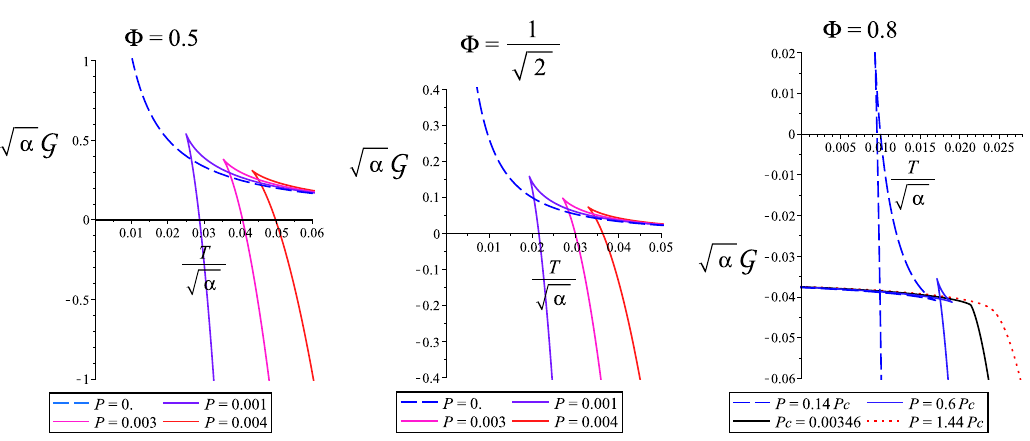
Figure 11 . Thermodynamic potential in grand canonical ensemble, for three (cid:12)xed (cid:8). Given 1 p < (cid:8) = 0 : 8 < 1, it is observed a critical isobar (black dash-dotted line) for which a critical point 2 appears.